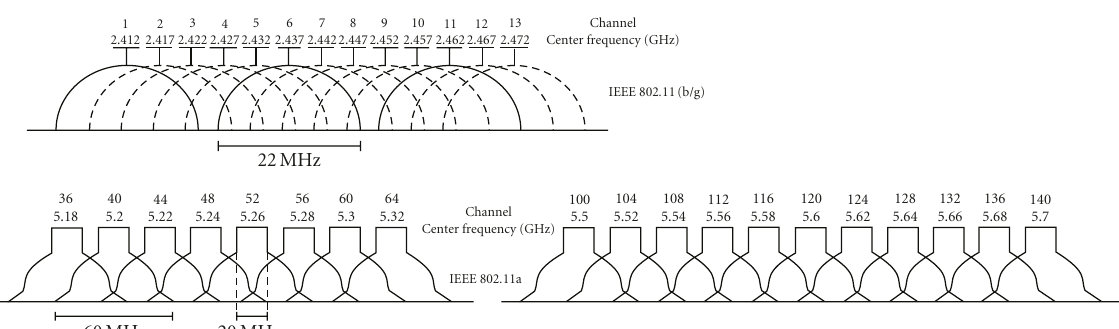
Figure 1: Physical deployment of FloorNet.